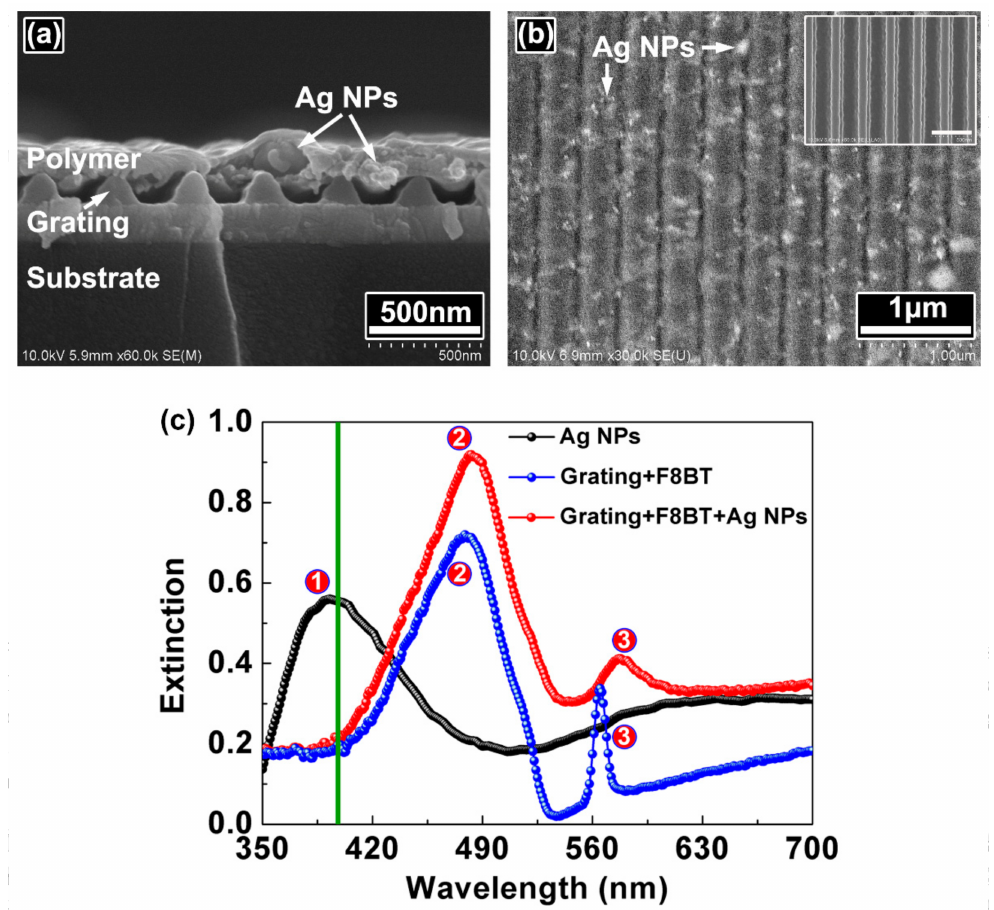
Figure 2. SEM images of ( a ) the cross section and ( b ) the top view of the periodic-random compound cavity. The inset in ( b ) shows the SEM image of the grating without a polymer cladding. The scale bar is 500 nm. ( c ) Extinction spectra of Ag NPs (black filled circles), the grating coated with polymer (blue filled circles), and the grating coated with polymer and Ag NPs (red filled circles). The green line indicates the wavelength of the pump light. Symbols 1 (cid:13) , 2 (cid:13) , and 3 (cid:13) indicate the corresponding extinction